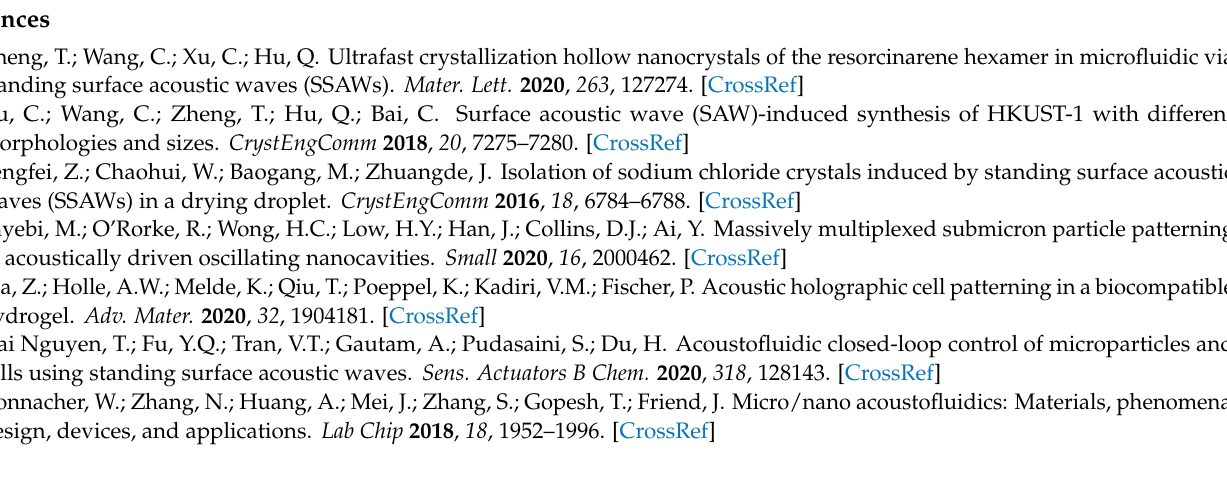
Figure 8. The highest fluid temperature of the different flow rates when the input voltage was 0.5 V. 154